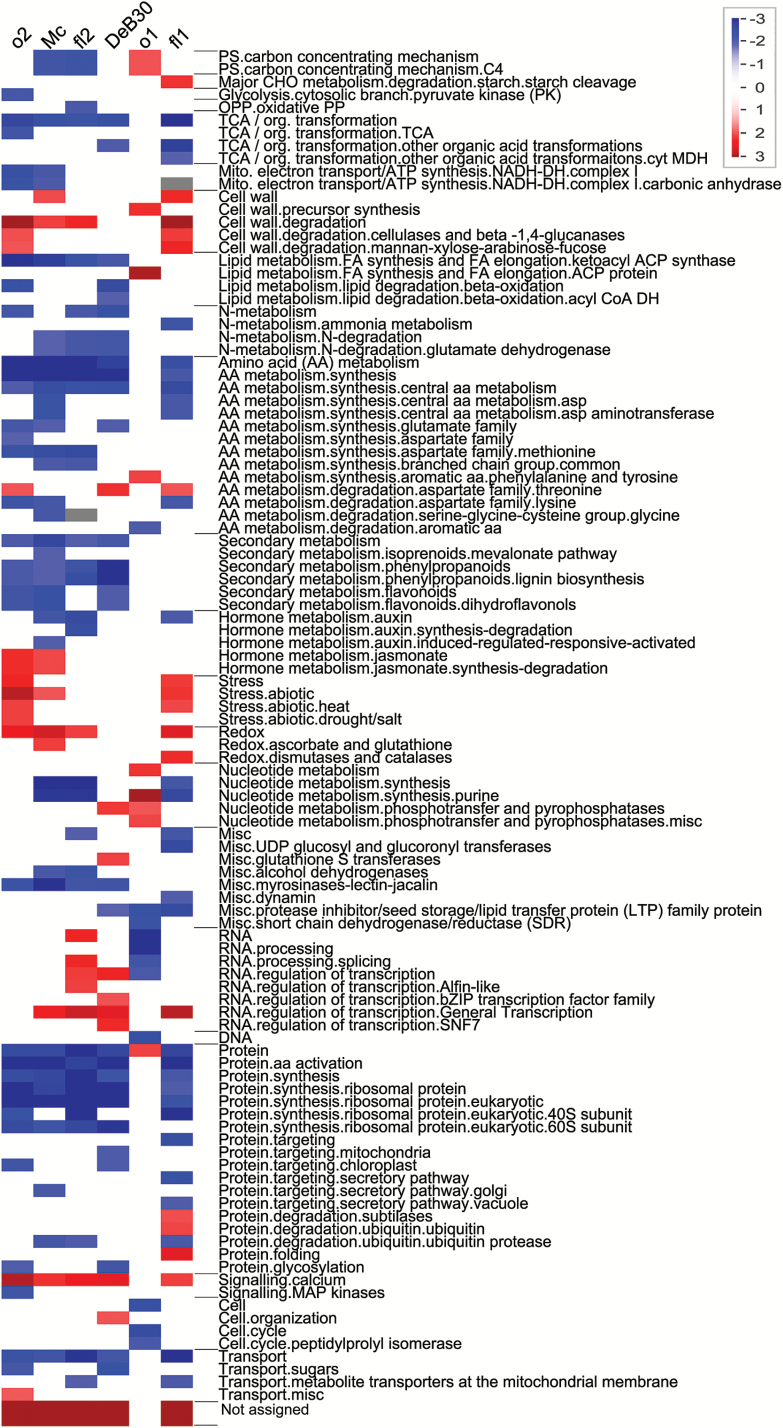
Protein over-representation analysis of opaque endosperm mutants. PageMan graphical visualization of enriched pathways for each opaque mutant and corresponding fold-change values compared with WT. Red boxes indicate increased abundance for proteins belonging to a specific function or annotation bin of the corresponding mutant, while blue indicates a lower abundance. Lines indicate upper and lower boundaries of each specific functional bin as determined by PageMan.